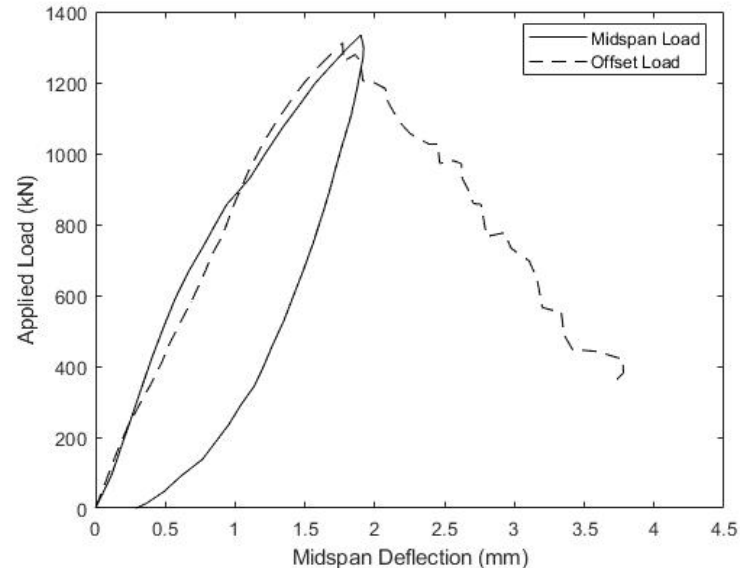
Figure 13. Beam B1 Ultimate Load-Displacement Response.